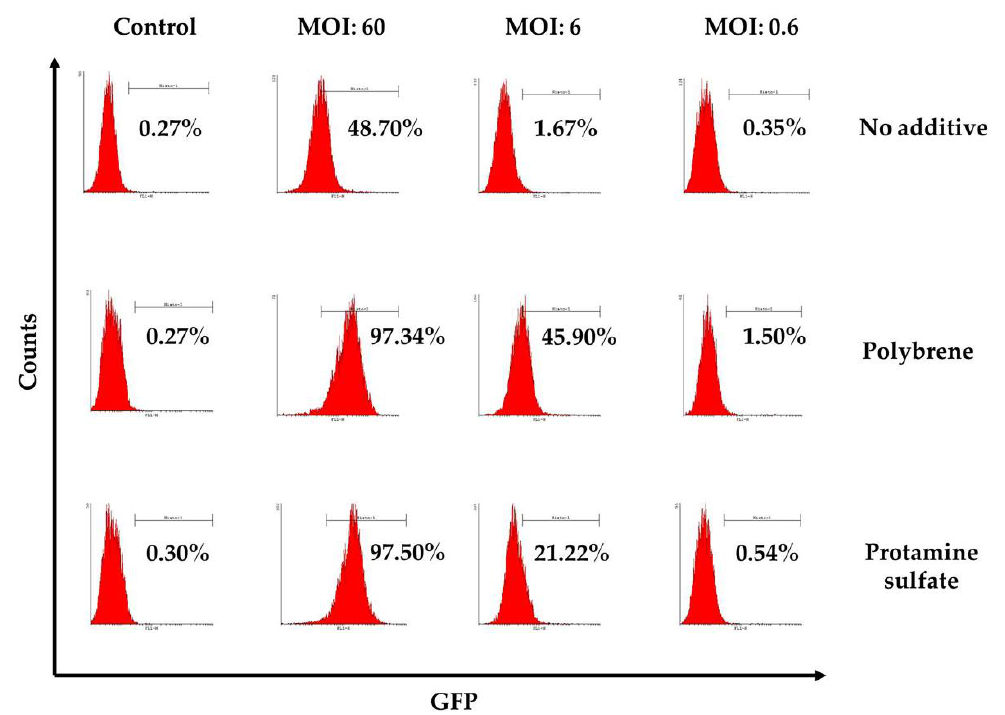
Figure 4. Representative flow cytometry results, three days post transduction with a conventional lentiviral vector expressing the green fluorescence protein in the presence or absence of transduction enhancers (polybrene or protamine sulfate). The percentage of GFP-positive cells is displayed on each histogram. Mock-transduced cells served as a negative control. GFP: green fluorescence protein.